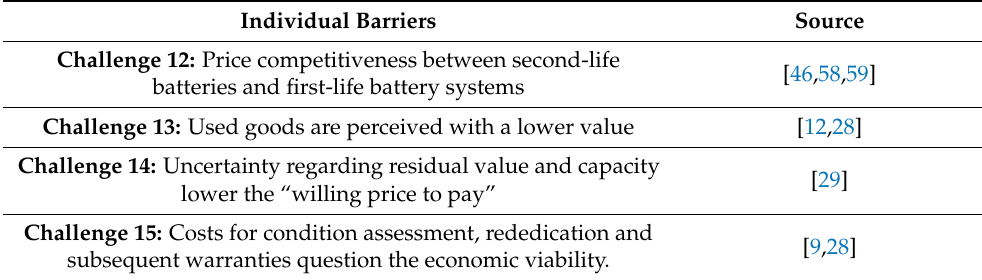
Table 4. The main barriers regarding